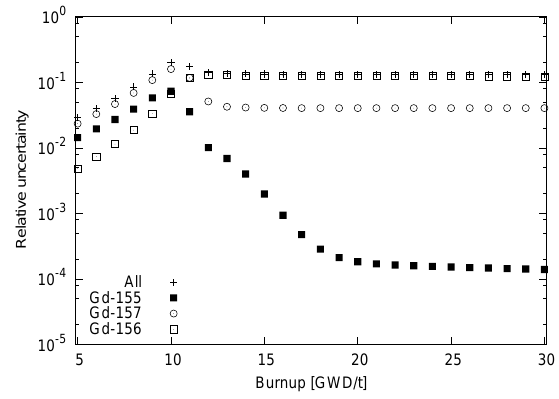
Figure 11. Nuclear data-induced uncertainty in Gd-157 number density during burnup